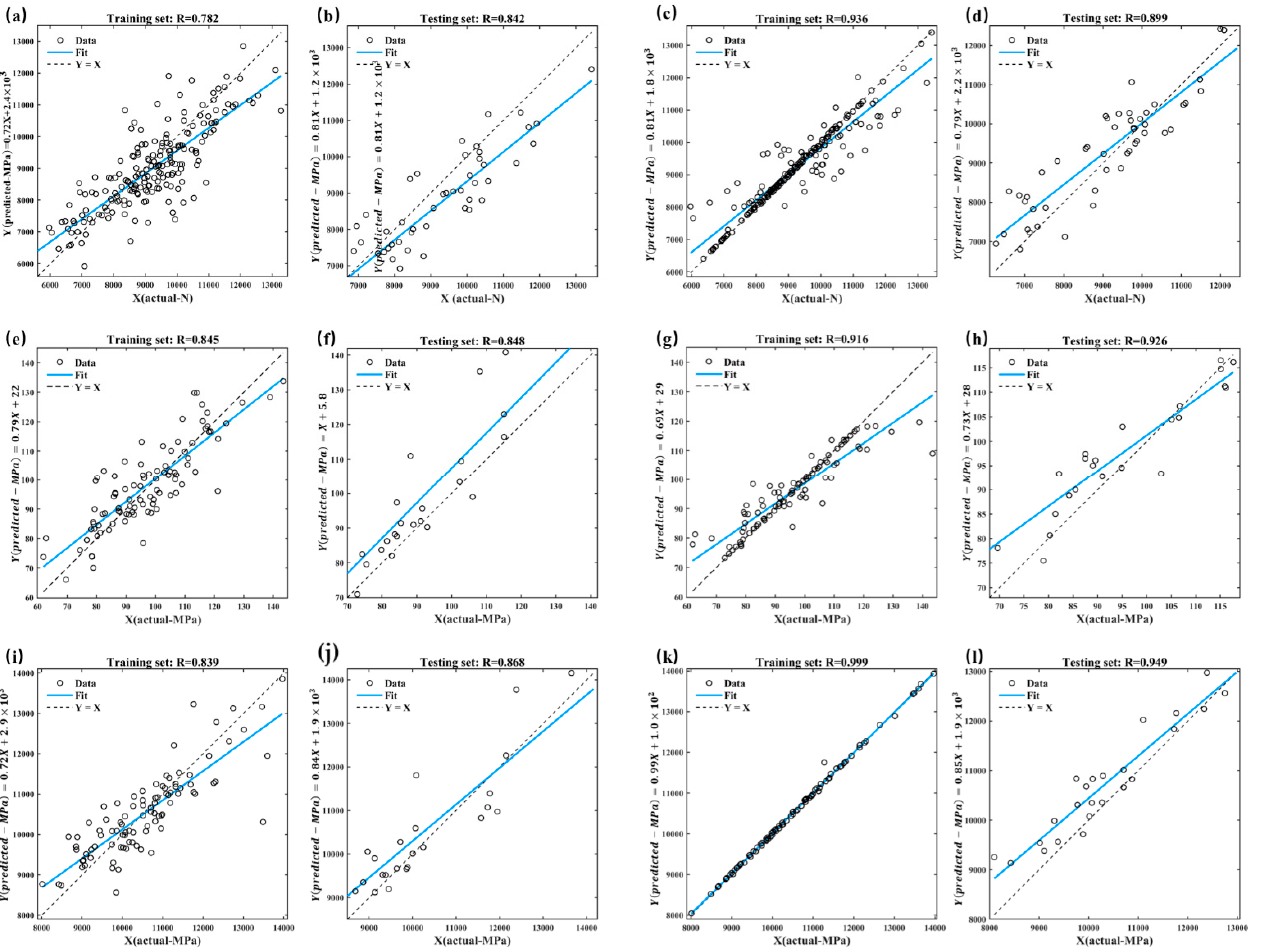
Figure 3. Relationship between the actual and predicted values of the ANN and SVM models for mechanical properties: ( a , b ) and ( c , d ) short-span shear stress, ( e , f ) and ( g , h ) MOR, ( i , j ) and ( k , l ) MOE. (j)